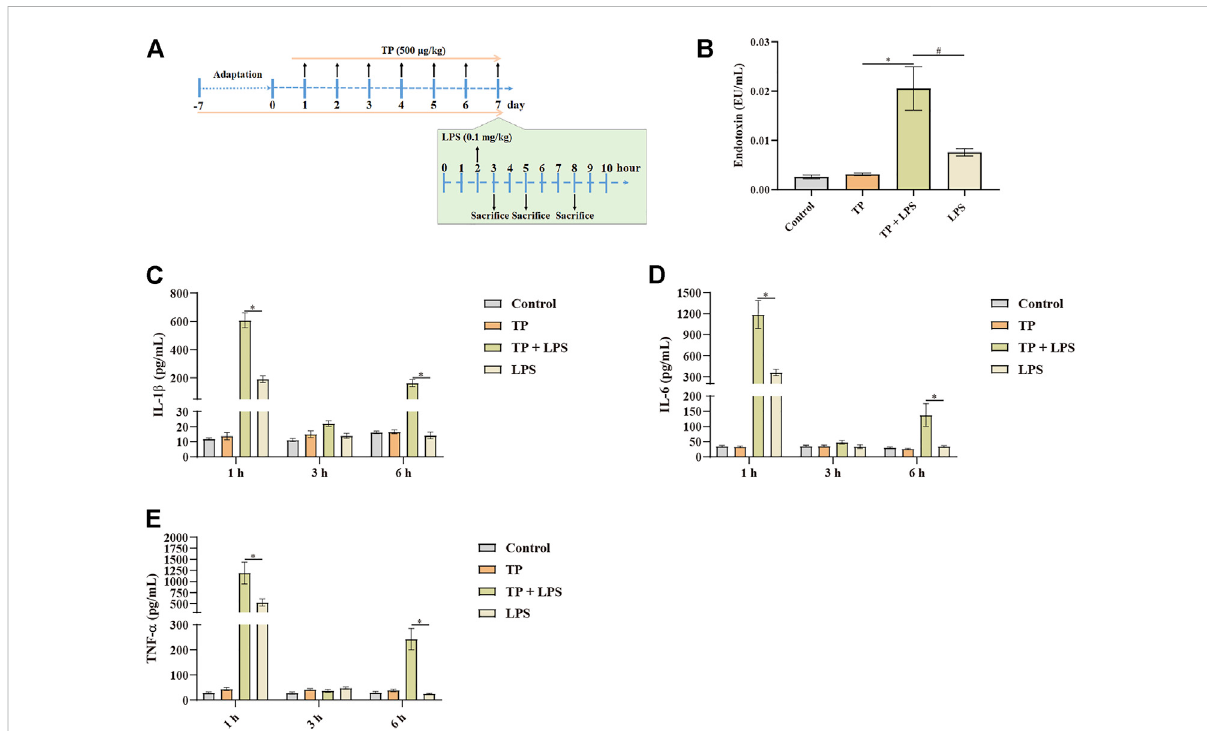
FIGURE 5 MalfunctioningofmacrophagesinTP-inducedindirecthepatotoxicity. (A) Schematicpresentationoftheexperimentalproceduretoinvestigate the time-dependent release of in fl ammatory factors in mice treated with TP (500 μ g/kg) and LPS (0.1 mg/kg). (B) Serum endotoxin content in mice treatedwithTPandLPS( n =8)6 hafterLPSinjection. (C – E) ChangesinserumTNF- α ,IL-6,andIL-1 β inmiceafterthetreatmentofTPandLPS( n =8). Results were expressed as means ± SEM. Statistical analysis was performed using One-way ANOVA and Two-way ANOVA followed by Tukey ’ s Multiple Comparison Test. p < 0.05 was considered to be statistically